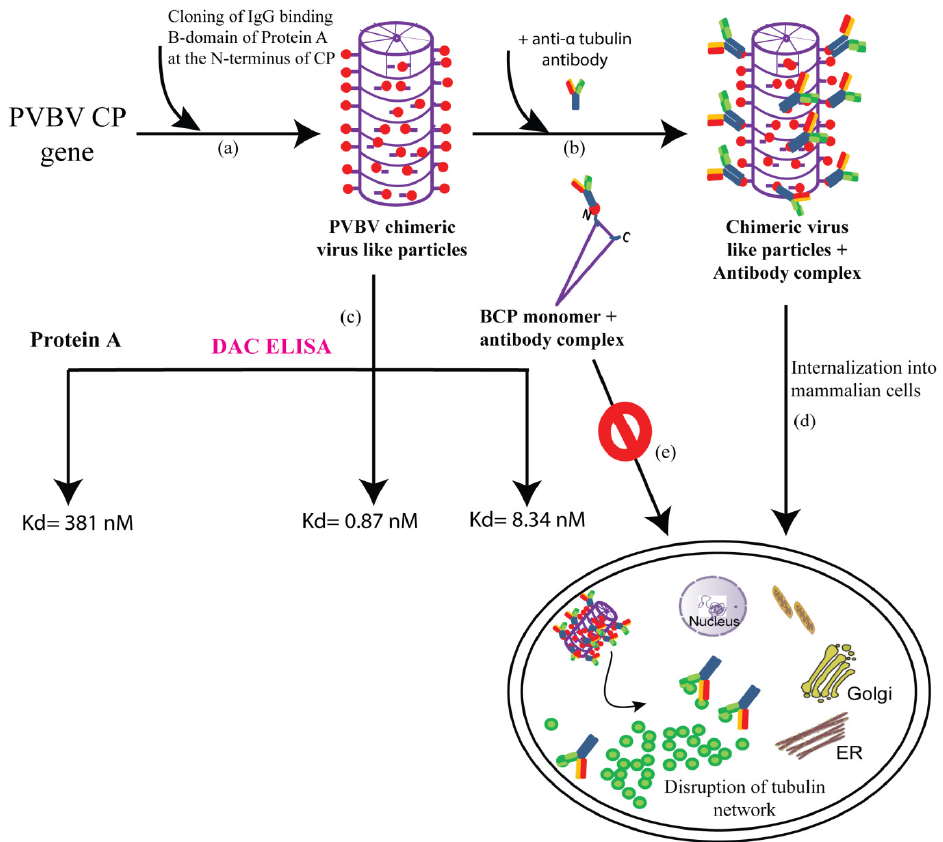
Figure 3. Schematic representation of the generation of chimeric VLPs and their potential applications ( a ) IgG-binding B-domain is cloned at the N-terminus of CP gene which assembles to form PVBV chimeric VLPs with each subunit expressing the B-domain at its N-terminus ( b ) Incubating the PVBV chimeric VLPs with anti-α tubulin antibody led to the formation of chimeric VLPs + antibody complex ( c ) PVBV chimeric VLPs, protein A as well as the monomer BCP (PVBV CP N-terminal fusion with B-domain) subunit + antibody complex were subjected to DAC ELISA (direct antigen coating-enzyme linked immunosorbent assay) where an antibody unrelated to CP was used. The dissociation constant (Kd) for each of the complexes is depicted, indicating an approximately 500-fold higher antibody-binding affinity of chimeric VLPs when compared to protein A ( d ) chimeric VLPs + anti- α tubulin antibody complex could internalize into mammalian cells and deliver the functional tubulin antibodies, which caused the disruption of the tubulin network ultimately causing cell death ( e ) whereas the BCP monomer (Ni-NTA purified BCP after size exclusion chromatography) + antibody complex fail to enter the mammalian